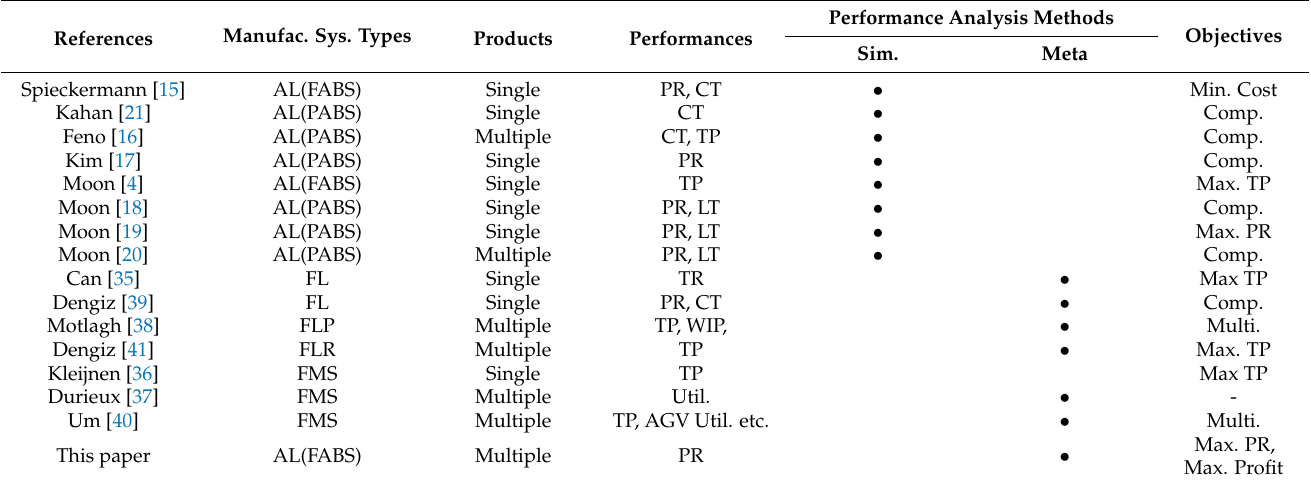
Table 1. Comparison of